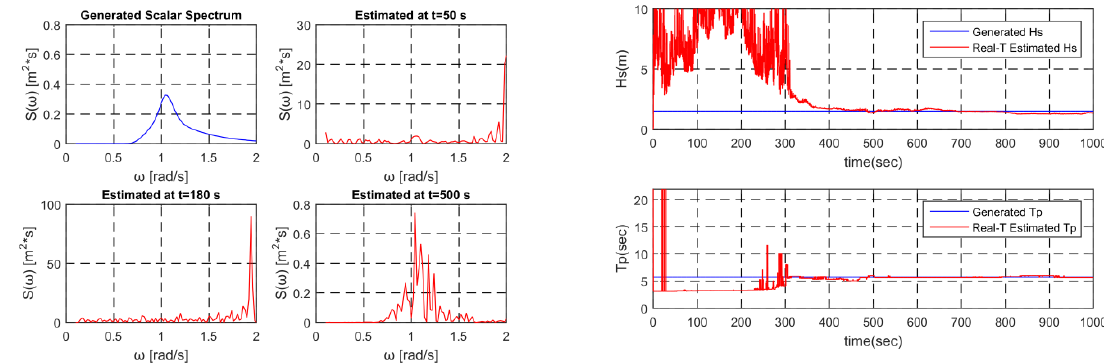
Figure 22. Generated and estimated spectrum/Evolution of parameters (Sea sate 1, Hs = 1.5 m, Tp = 6 s).